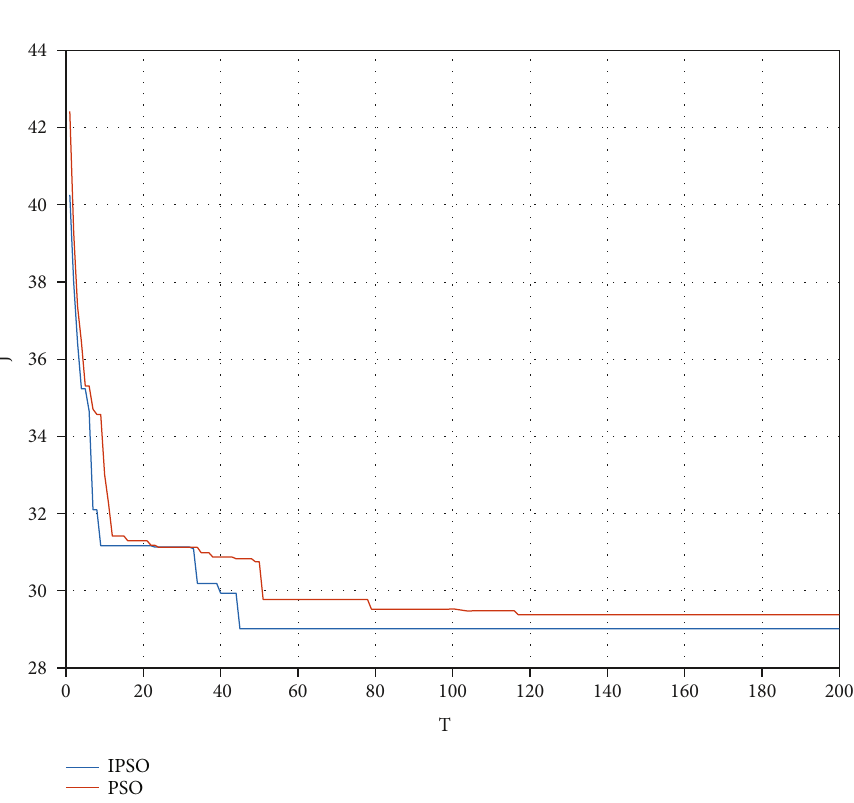
Figure 14: Comparison of IPSO